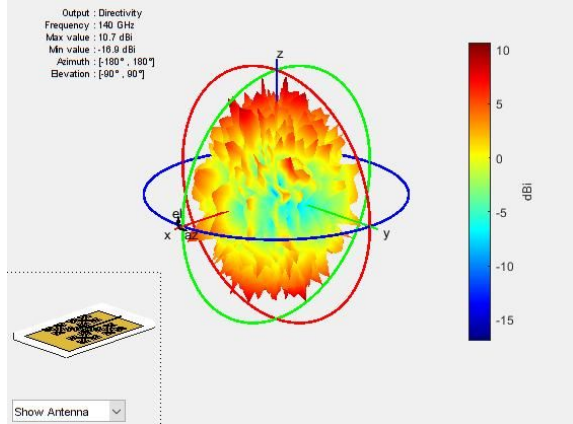
Figure 12. Minkowski fractal antenna pattern radiation.